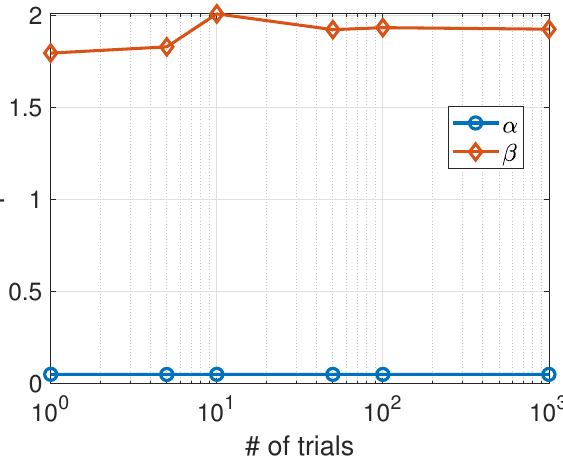
Figure 2. Predator–prey model. Average values of the parameters estimated using the Nelder–Mead algorithm as a function of the number of trials.